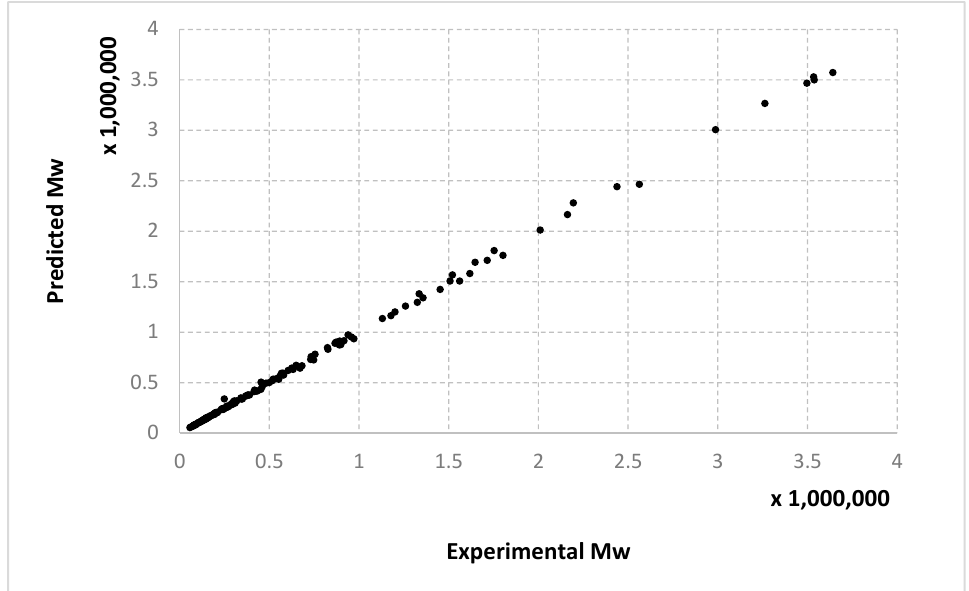
Figure 14. Predicted gravimetrical average molecular weight with the LMNNR-EA algorithm versus experimental data, setting 2, with data split into 67% for training and 33% for testing.